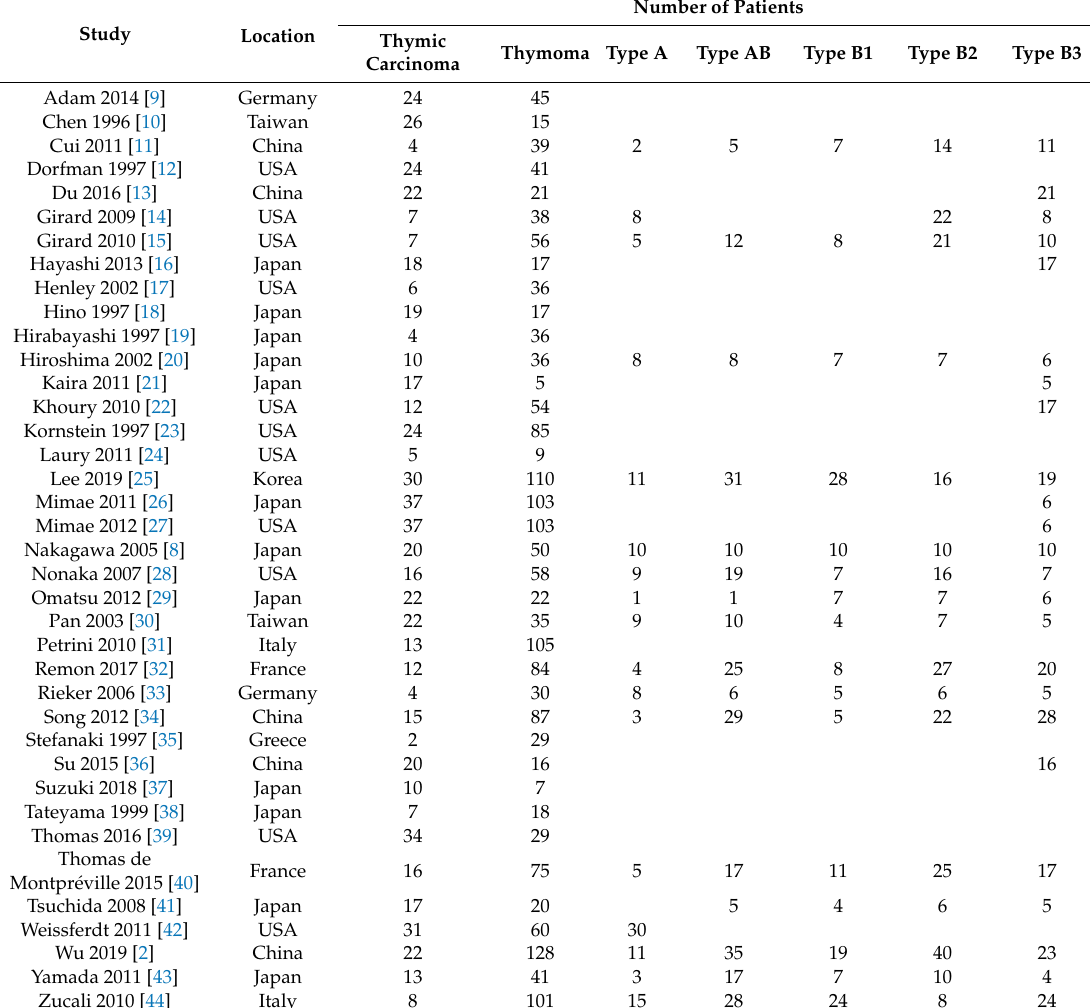
Table 1. Main characteristics of the eligible